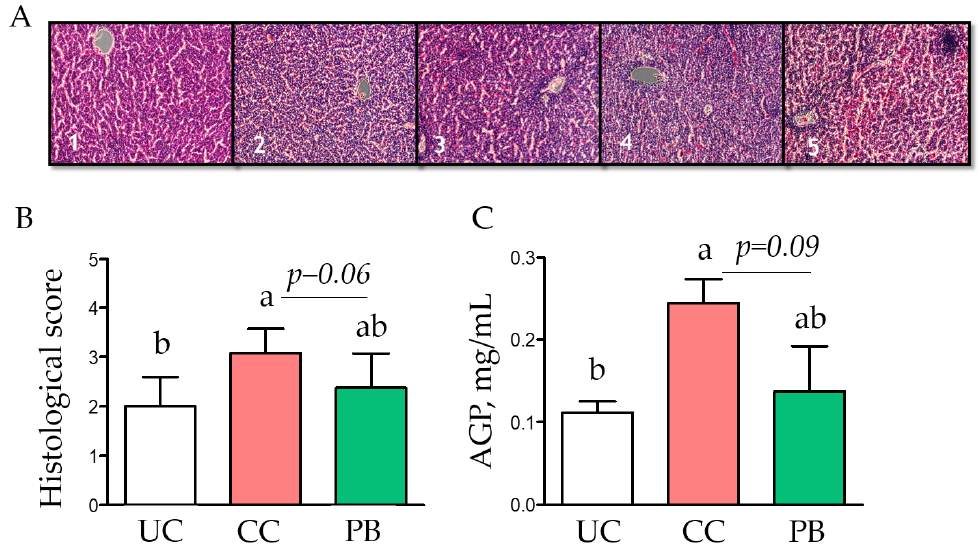
Figure 2. The systemic response to challenge was ameliorated by a dietary precision biotic. ( A ) Representative slides of the liver histology scoring system (20× magnification). ( B ) Mean liver histology scores of 8 chickens per treatment at 28 days of age. ( C ) Concentration of alpha 1-acid glycoprotein (AGP) in the plasma of chickens at day 28 measured by ELISA. One-way ANOVA with Tukey post-hoc test has been performed on all results; statistically significant differences ( p < 0.05) are indicated by different letters on the bars and trends are indicated by p -values. UC: unchallenged control; CC: challenged control; PB: precision biotic.